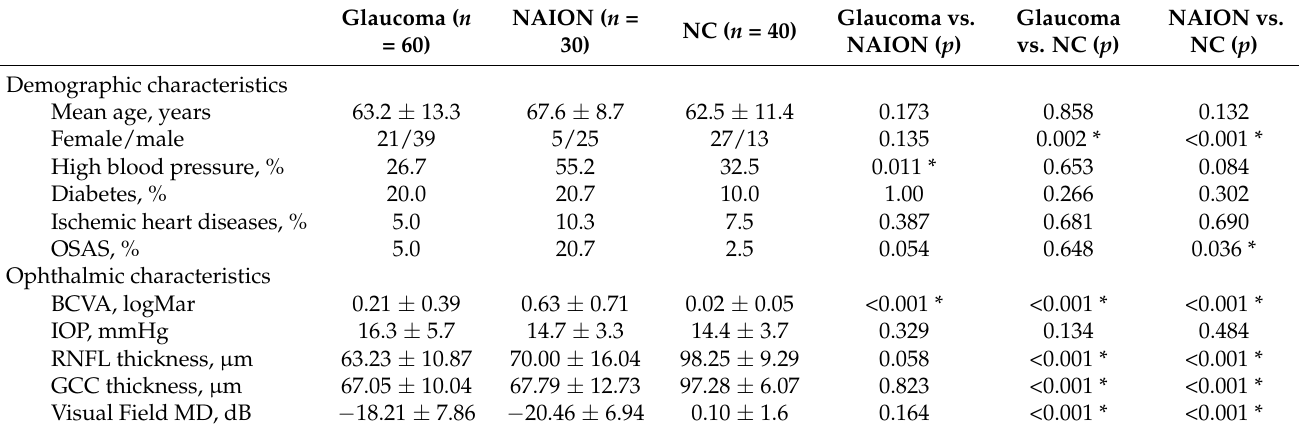
Table 1. Demographic and ophthalmic characteristics.